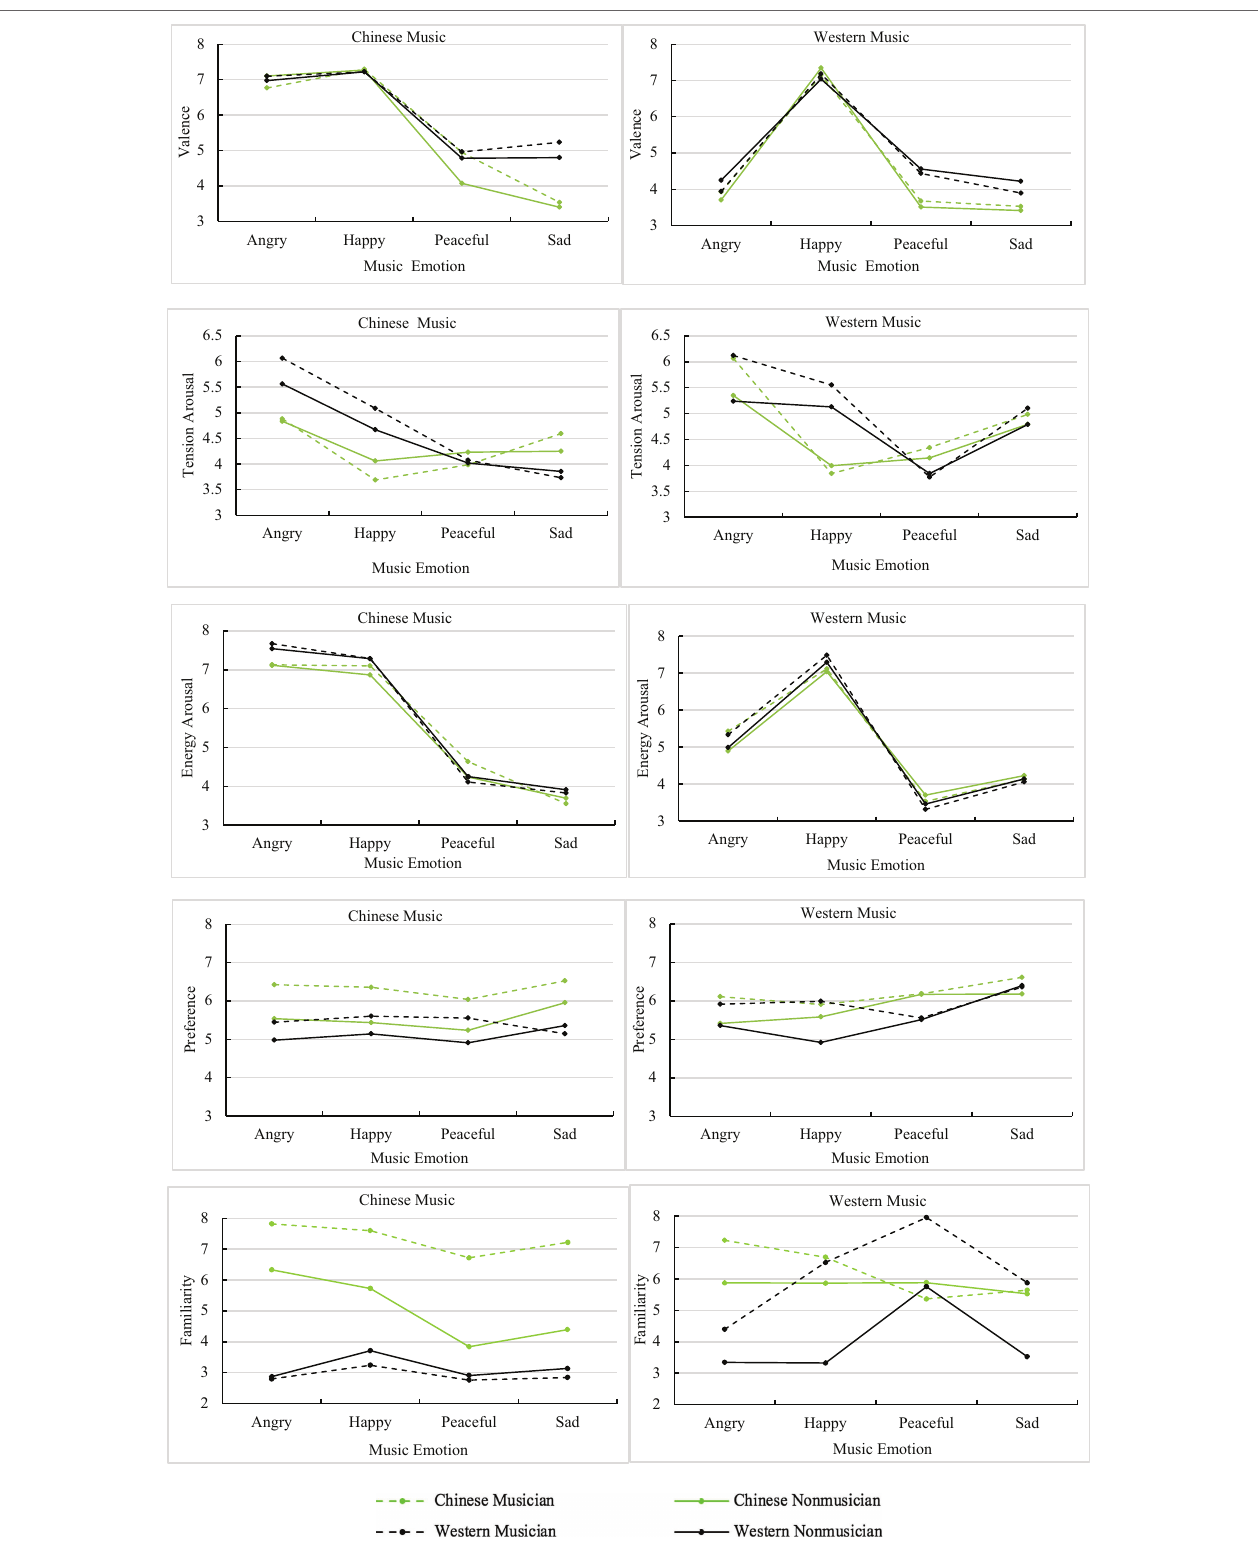
FIGURE 5 | Plots of the three-way interaction effects between musical culture, musical emotion, and listener group for valence, tension arousal, energy arousal, preference, and